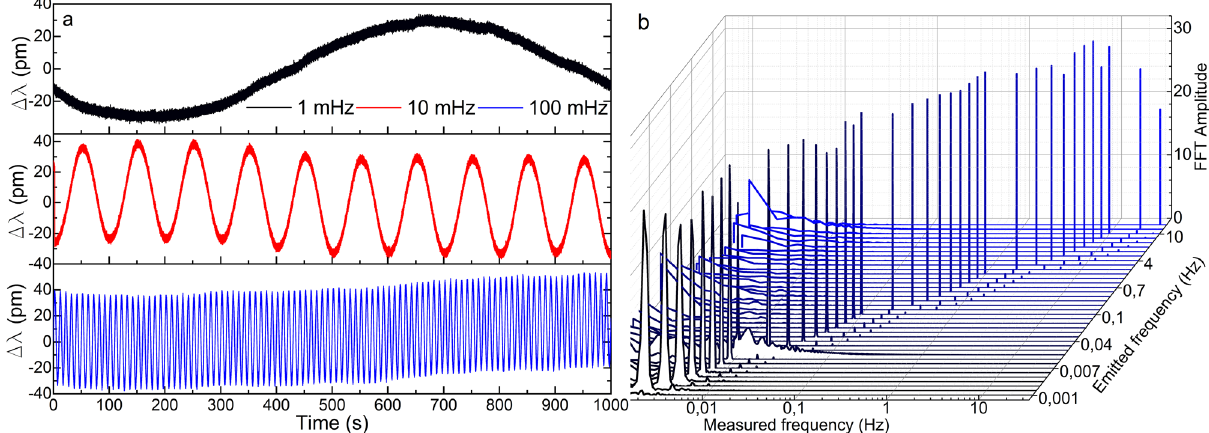
Figure 7. Results of the wavelength shift measurements in the manufactured optical device. ( a ) Time response of three representative cases. ( b ) FFT amplitudes for frequencies from 30 Hz down to 1 mHz for a sinusoidal signal of 1 Vpp. The Measured frequency axis is in logarithmic scale.